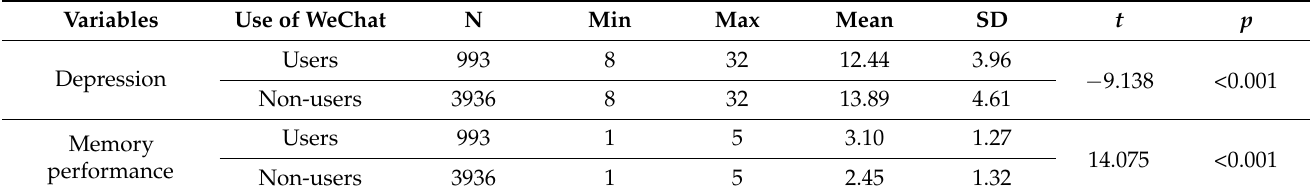
Table 2. Descriptive statistics for depression and memory performance scores by WeChat users and